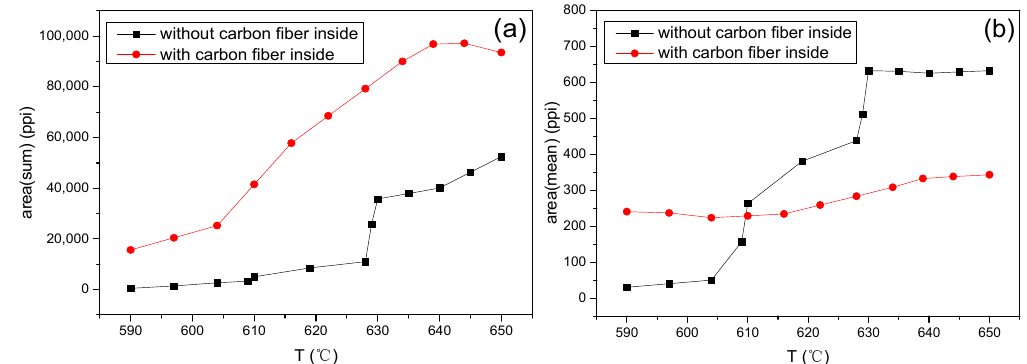
Figure 5. The curves of the cell area of the aluminum foam, in the early nucleation stage: ( a ) the sum cell area; ( b ) the average cell area.